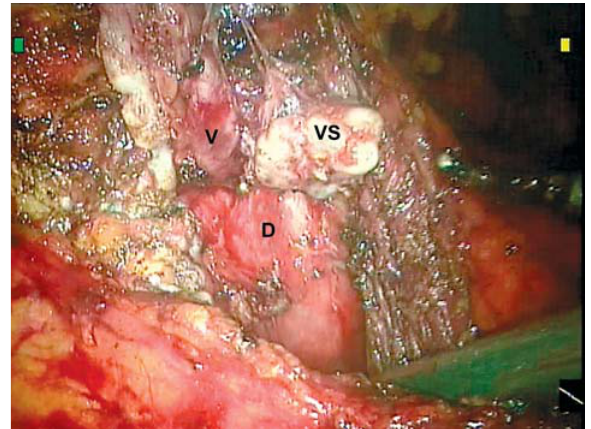
Figure 5 – Dissection of the bladder neck completed anteriorly while the posterior bladder neck is scored with electrocautery. B = bladder neck.